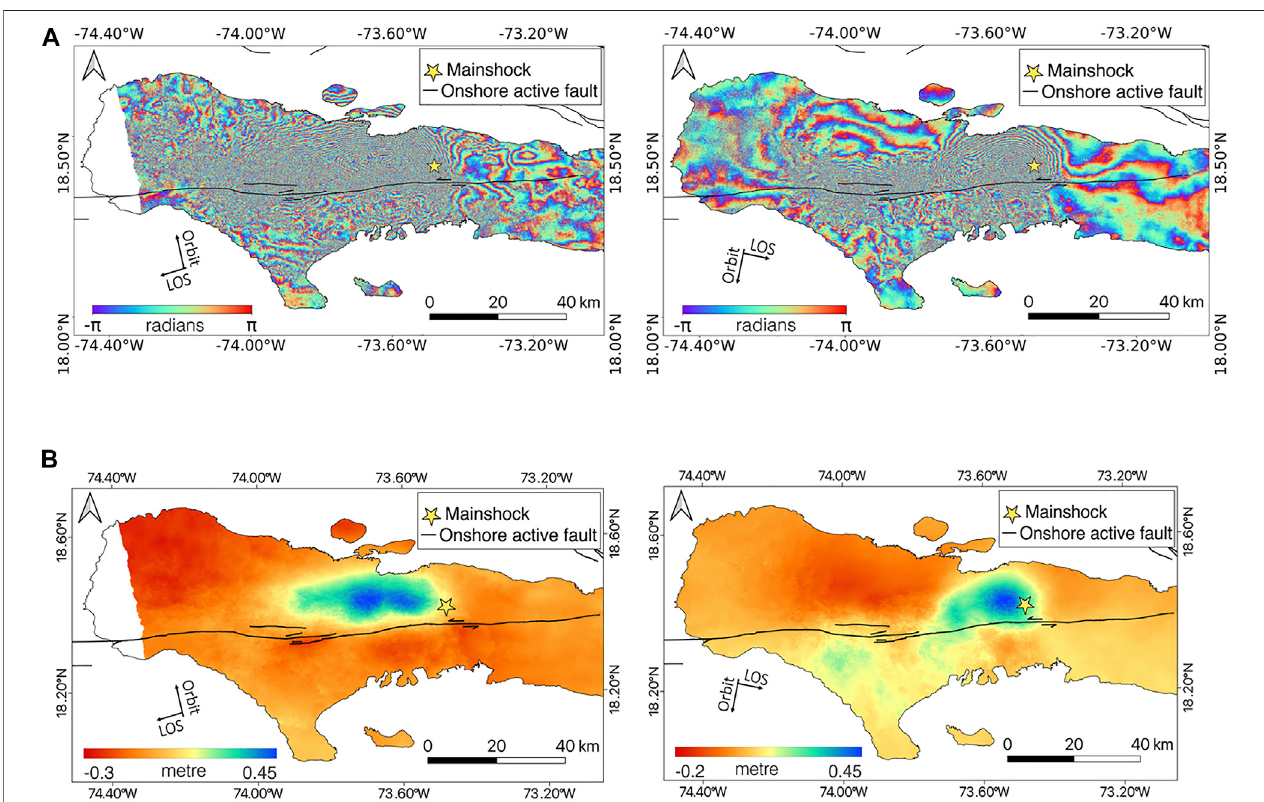
FIGURE7|(A) Co-seismicinterferogramsand (B) surfacedisplacementmapsobtainedbyprocessing(left)apairofSentinel-1SARimagesacquiredon05August and 17 August 2021 from ascending acquisition geometry, and (right) a pair of Sentinel-1 SAR images acquired on 03 August and 15 August 2021 from descending acquisition geometry. The yellow star indicates the earthquake epicentre. Black lines are onshore active faults from Saint-Fleur et al., 2020.